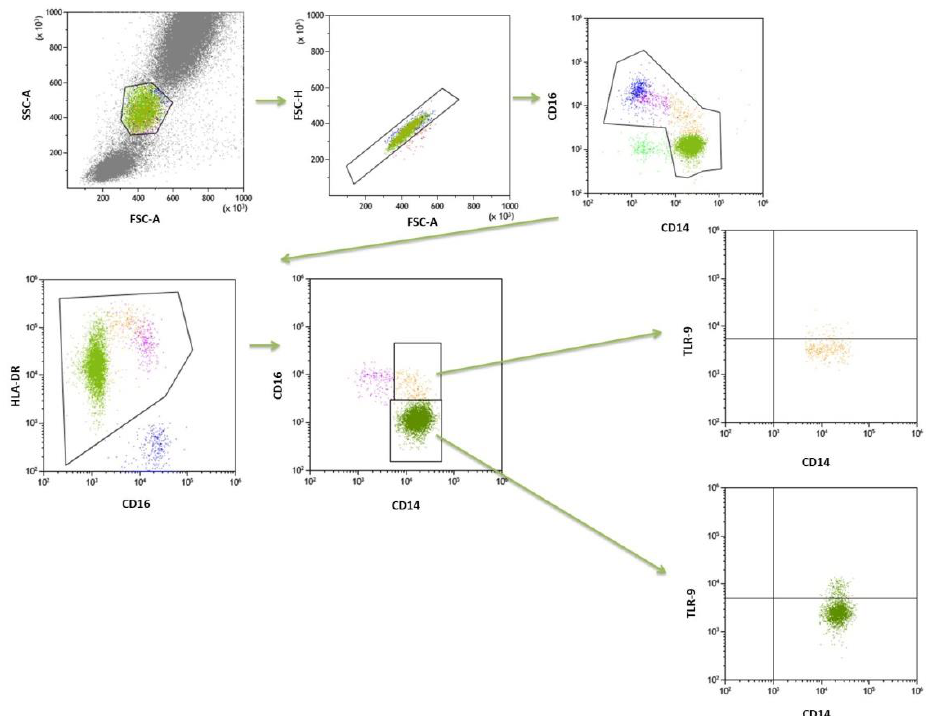
Figure 4. The gate strategy of monocytes.